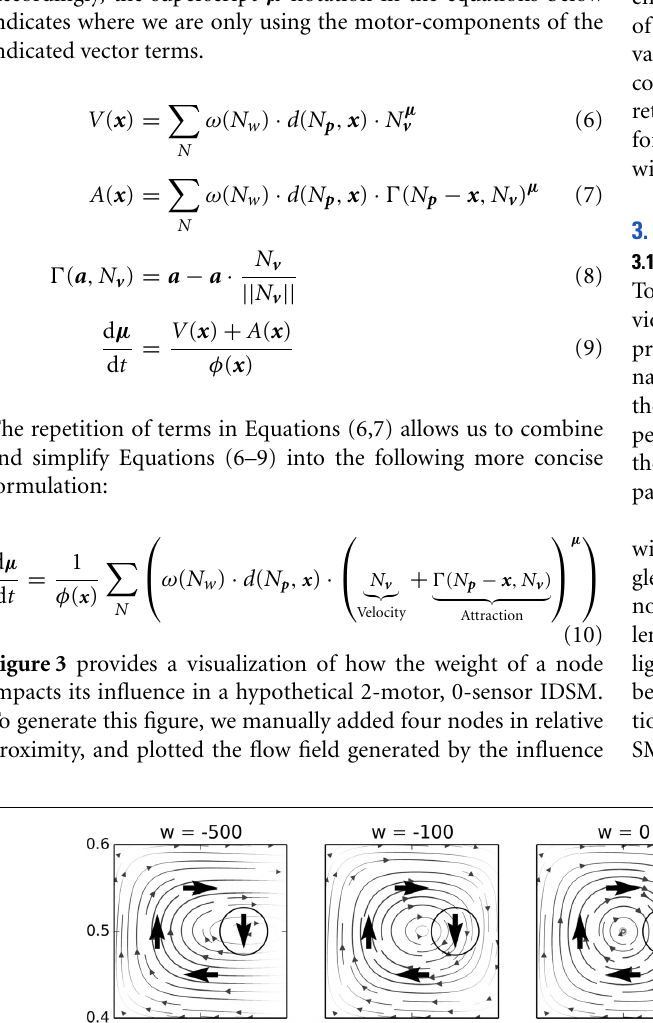
FIGURE 3 | Nodes with lower weights have less influence on system-dynamics. These plots show how the influence of a node decreases with its weight. Each plot shows the dynamics of the same in the same